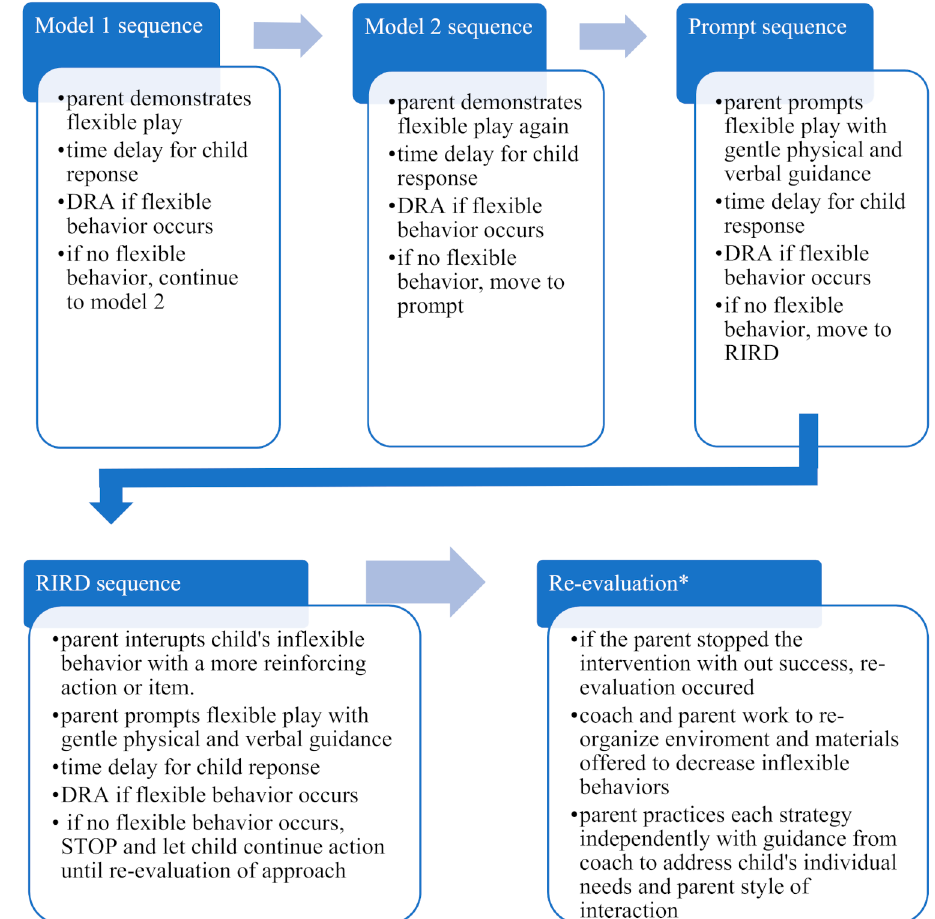
Figure 1. Sequence of Strategies During Intervention. The following sequences were possi- ble: Model 1 sequence = (model 1); Model 2 sequence = (model 1 + model 2); Prompt se- quence = (model 1 + model 2 + prompt); RIRD sequence = (model 1 + model 2 + prompt + RIRD). Re-evaluation* was planned for but not used. PI acted as coach in this